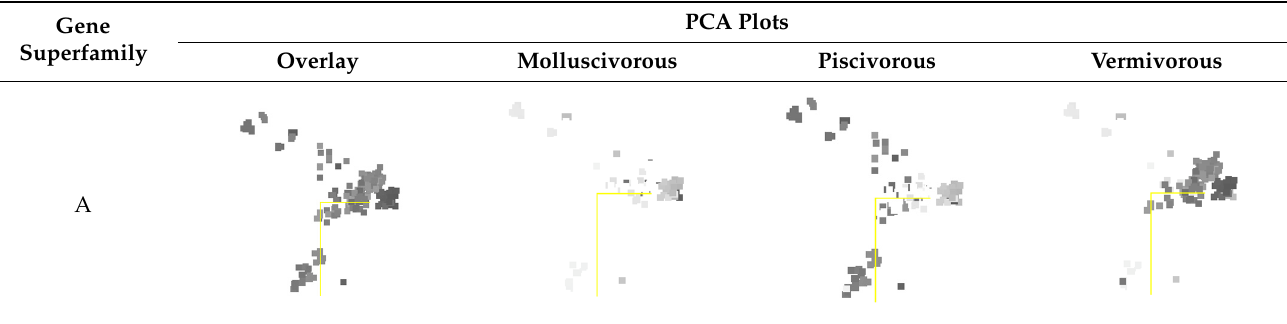
Table A1. Principal component analysis plots.